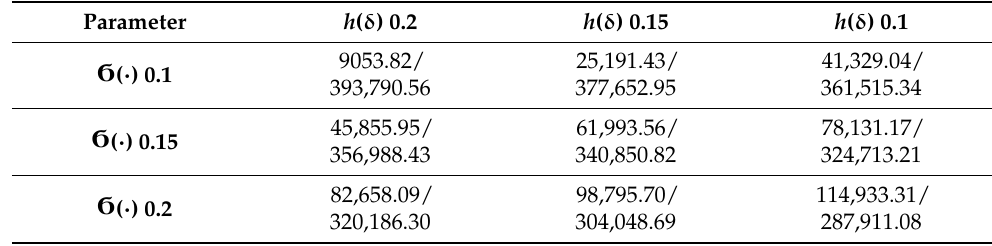
Table 7. Correlation of the Subordinate’s objective functional and the Principal’s objective functional using B.I.M. with the same parameters of the reward and penalty system. Table 8. Correlation of the Subordinate’s and the Principal’s objective functional using P.B.I.M. with the same parameters of the reward and penalty system.